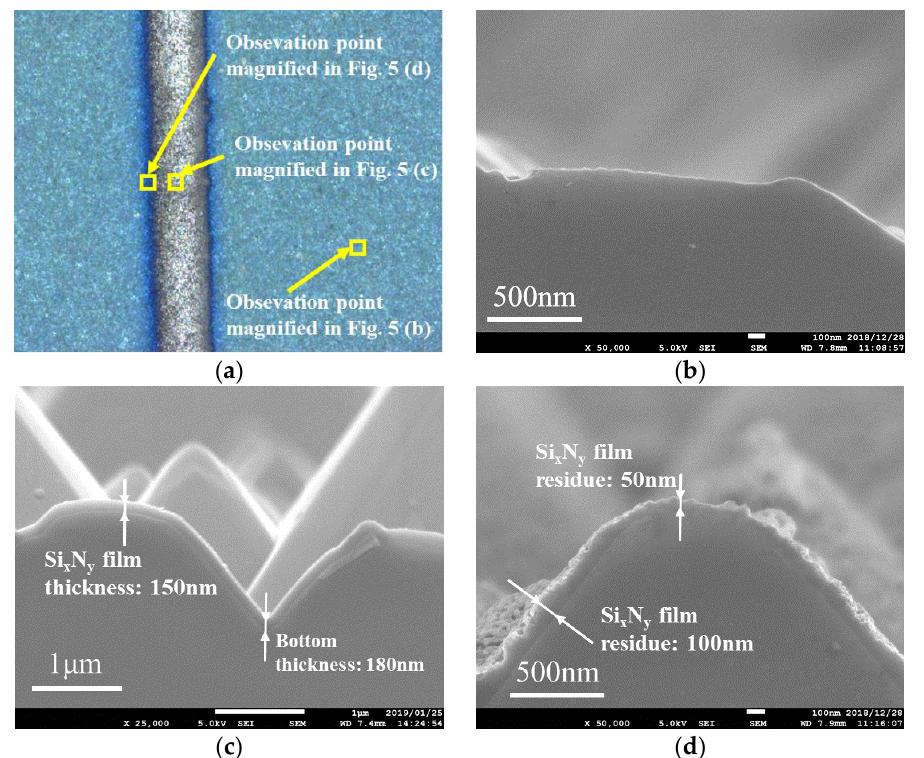
Figure 5. SEM images of silicon substrate’s cross-sections in etching region when Ar:CF 4 = 700:300 sccm and V pp = 9.8 kV, and etching time t e = 180 s: ( a ) SEM observation points; ( b ) central region of groove; ( c ) untreated cross section; ( d ) edge region of the groove.